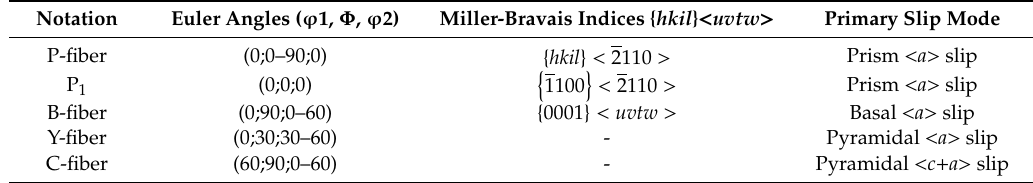
Table 1. Ideal simple-shear textures in hexagonal close-packed metals (after Li [51], and Beausir et al. [52]).